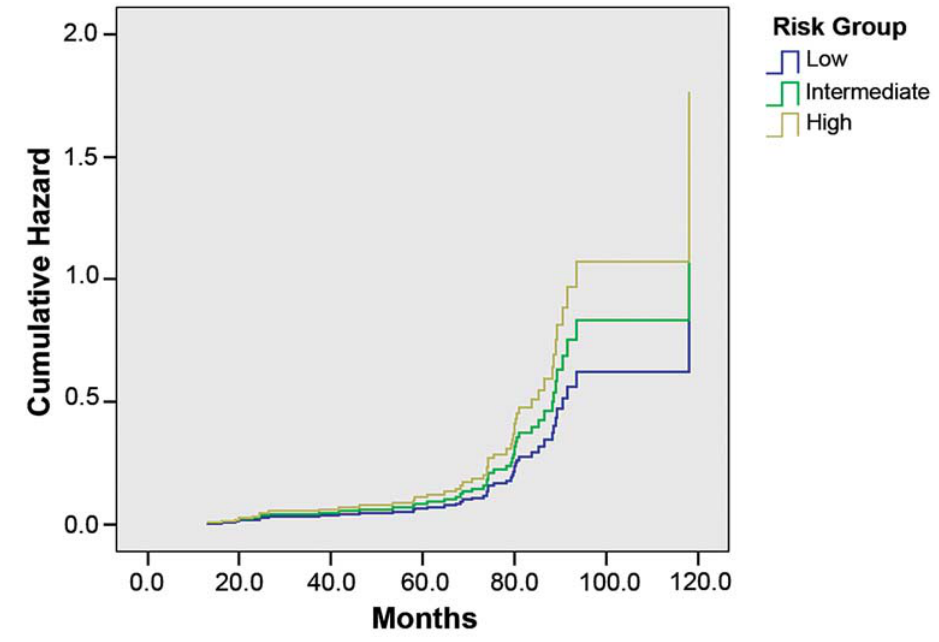
Figure 3 – Hazard functions according to the risk group for biochemical